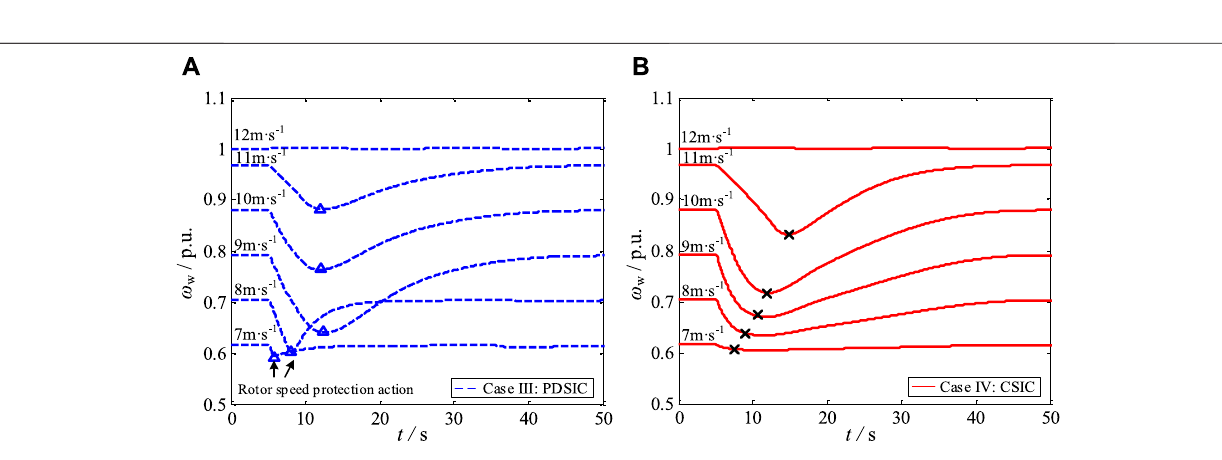
Frontiers in Energy Research |